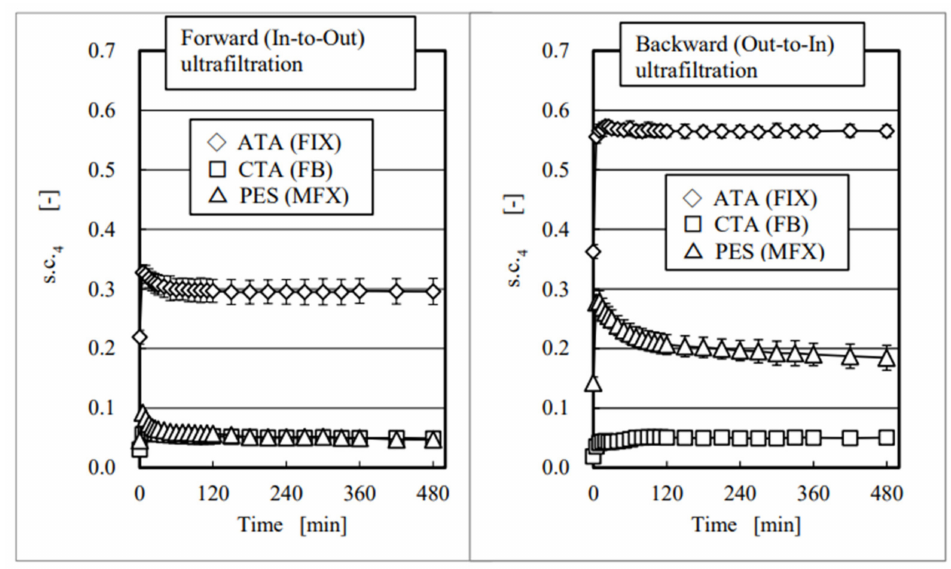
Figure 4. Physicochemical structures of the dialysis membrane.